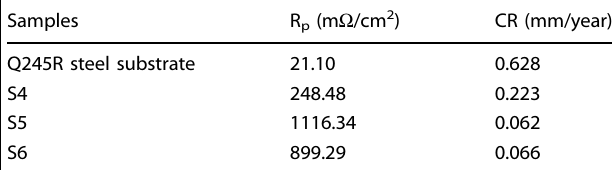
Table 6. Polarization resistance (R p ) and corrosion rate (CR) of Q245R steel substrate and Inconel 625 coatings: S4, S5, S6. Samples